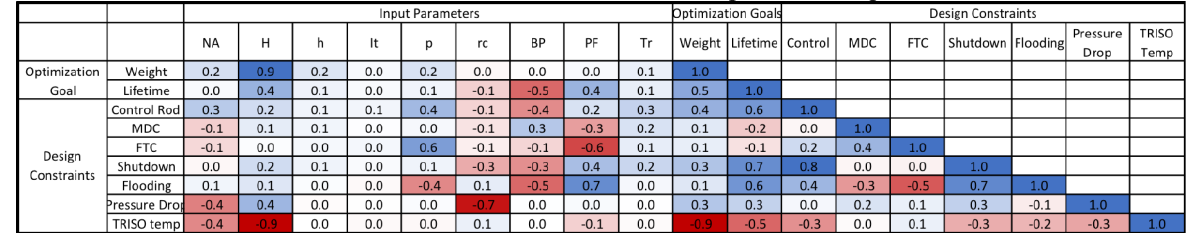
Table 3. Pearson correlations between Inputs and Outputs.